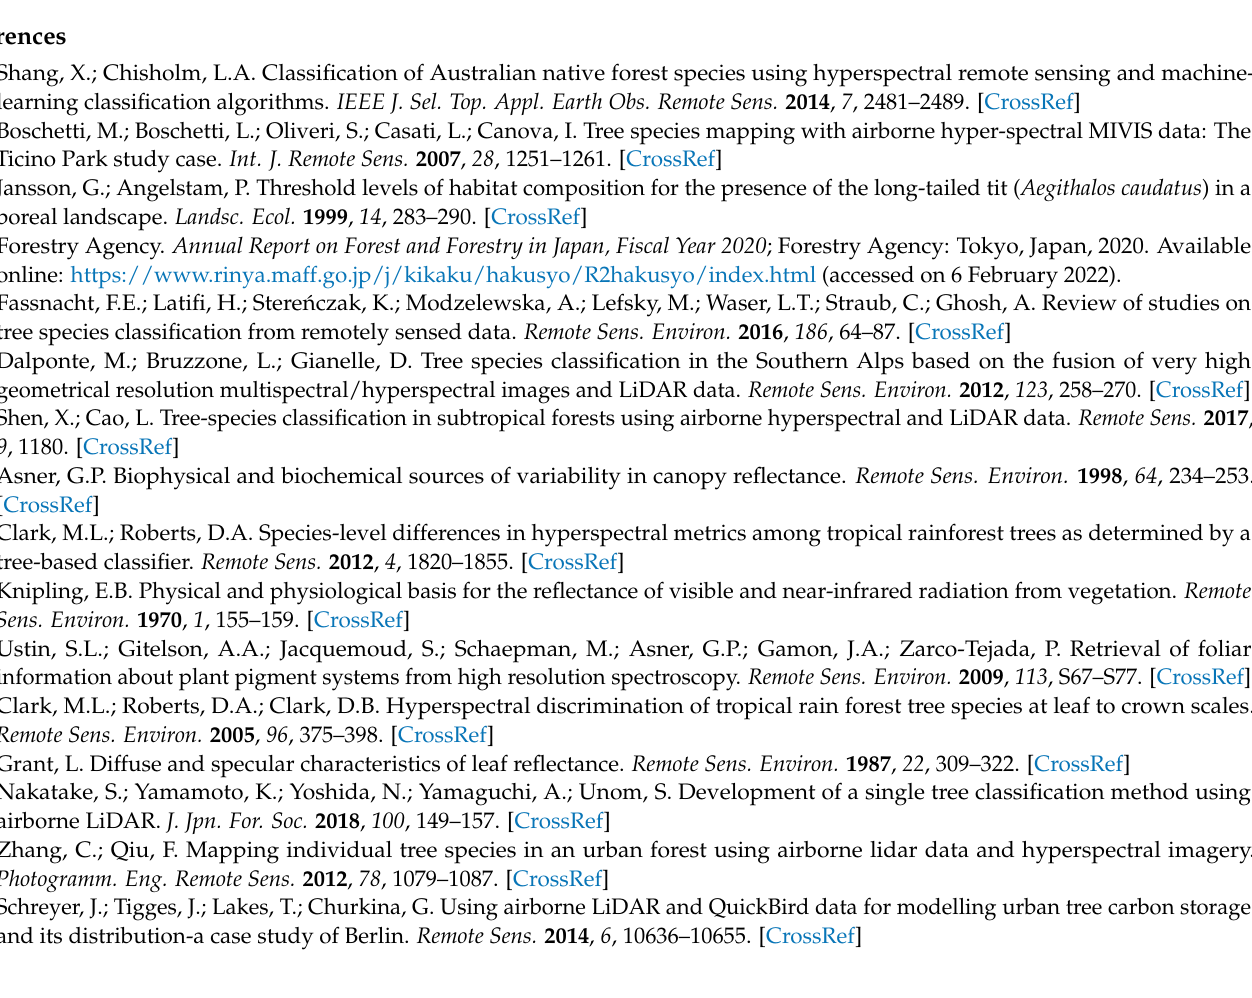
Table S5: Details on classification accuracy of inventory